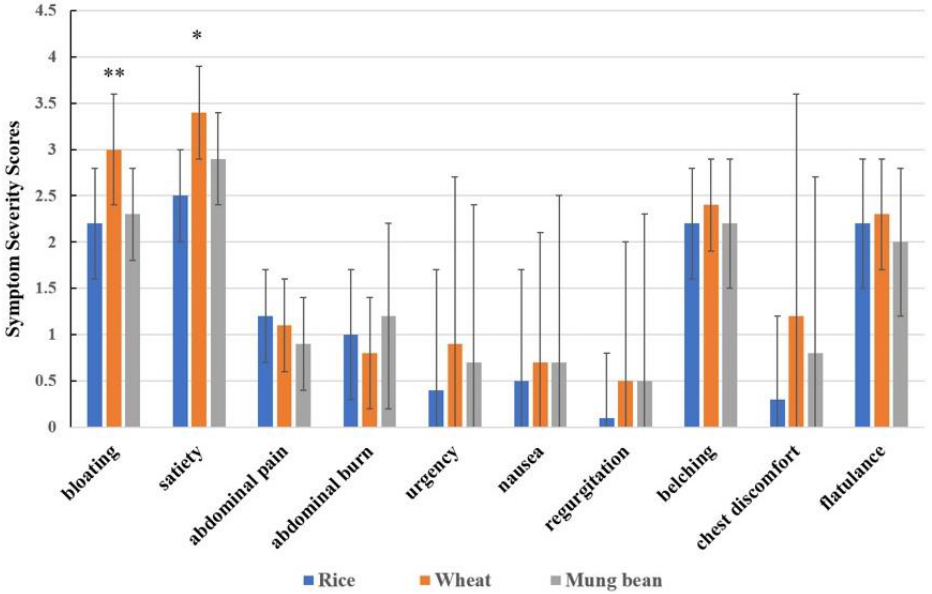
Figure 3. Gastrointestinal symptom scores (visual analogue scale, VAS 0–10) in non-C IBS patients after ingestion of different test meals (data expressed as mean ± SEM). ** = p < 0.05 wheat vs. rice and wheat vs. mung bean, * = p < 0.05 wheat vs. rice.